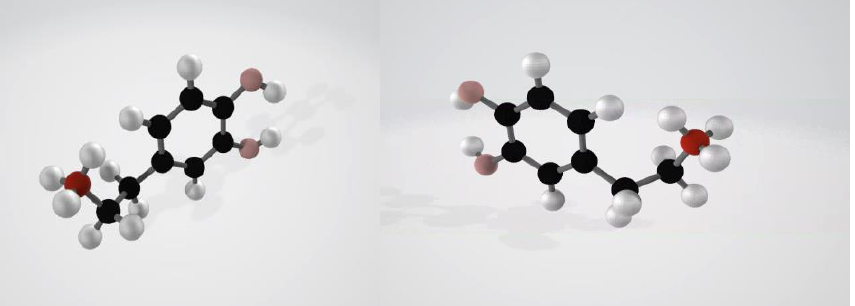
Figure 3. Sample 3D models of molecules having a different chemical composition, in particular additional alkyl CH 2 group in the right image.